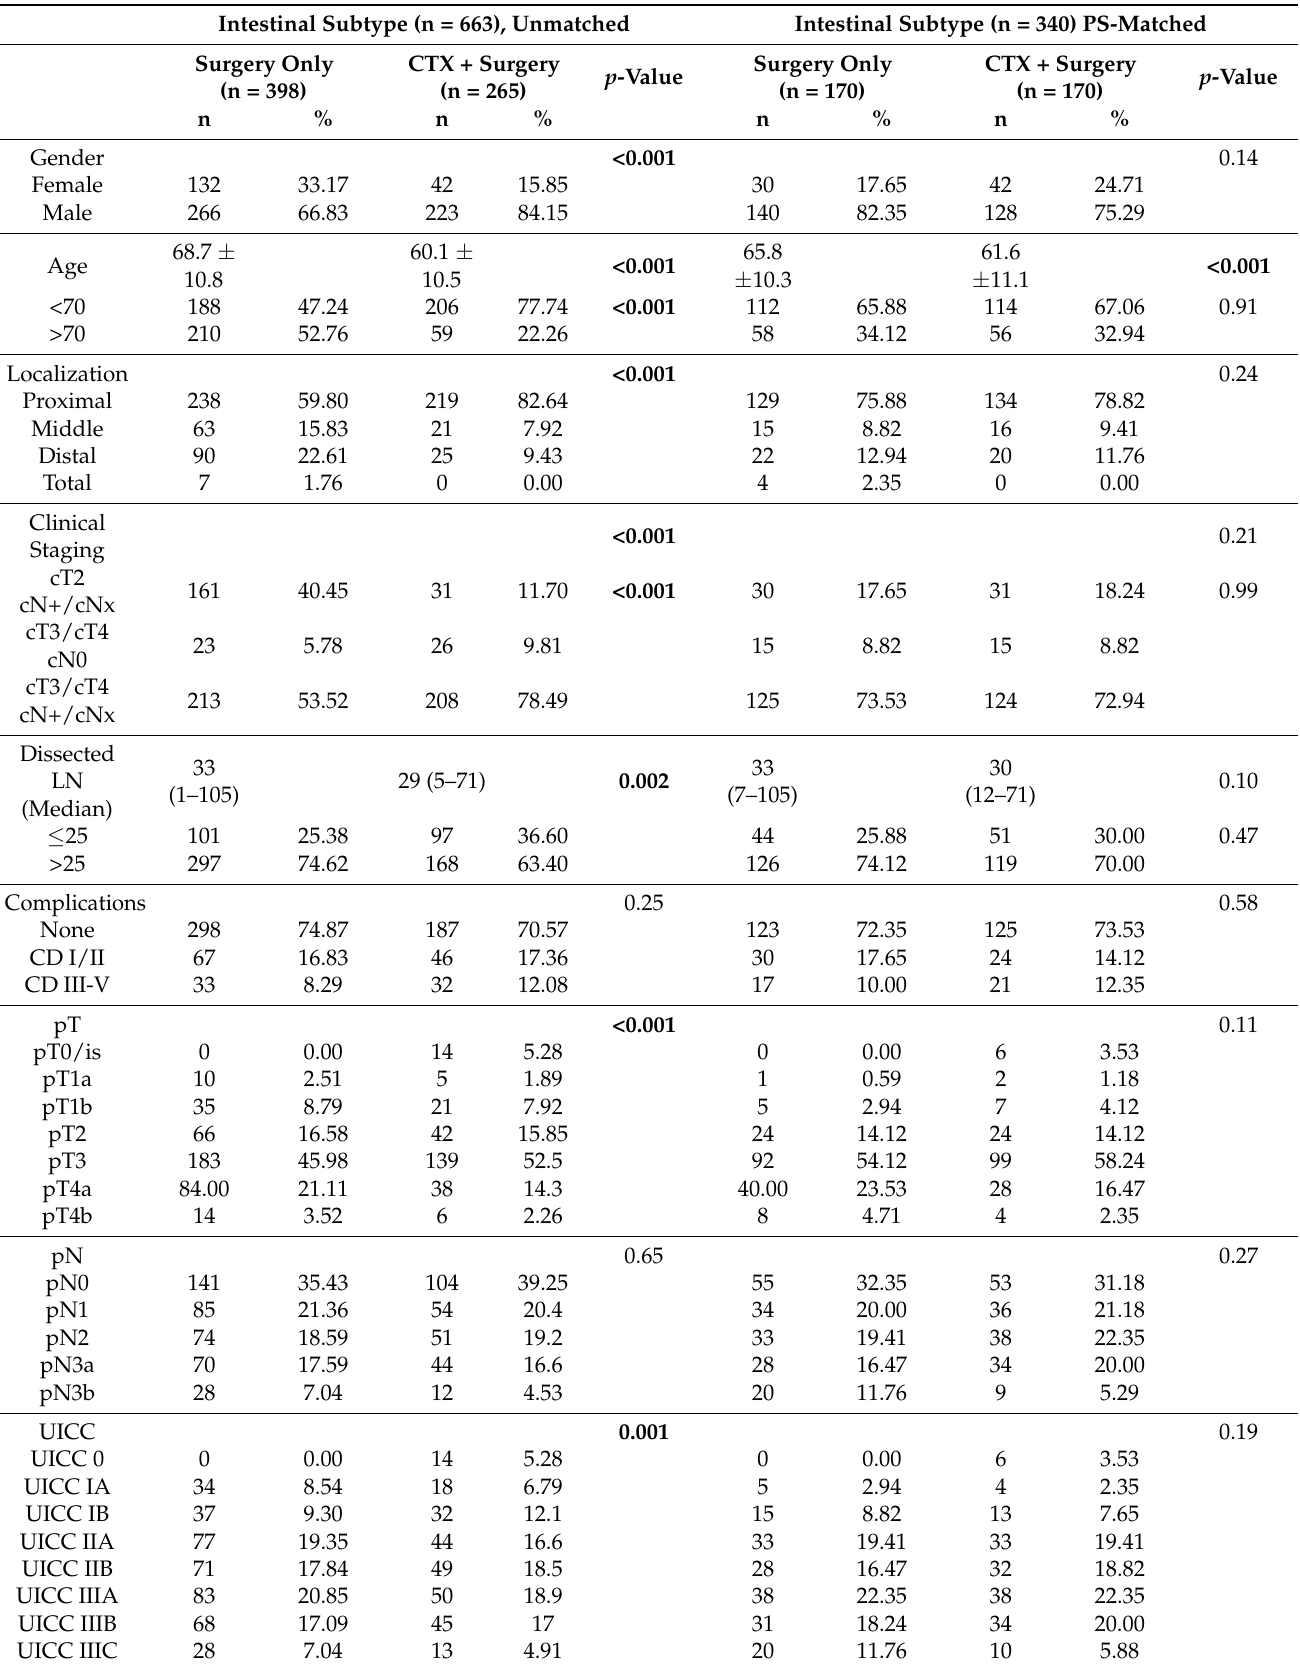
Table 1. Baseline characteristics for patients with intestinal Lauren subtype before and after propensity score matching (PSM). Intestinal Subtype (n = 663),